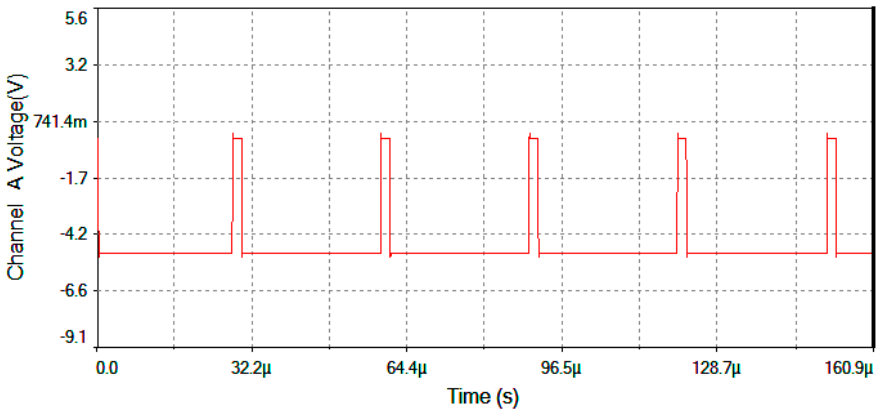
Figure 20. V gate voltage generated by the pulse generator circuit (fixed frequency f = 32.59 kHz). Figure 17 represents output voltage after the analog Multiplier ( V multiplier , Figure 4). Figure 18 represents output voltage after the Angle analog integrator ( V theta , Figure 4). Figure 19 represents